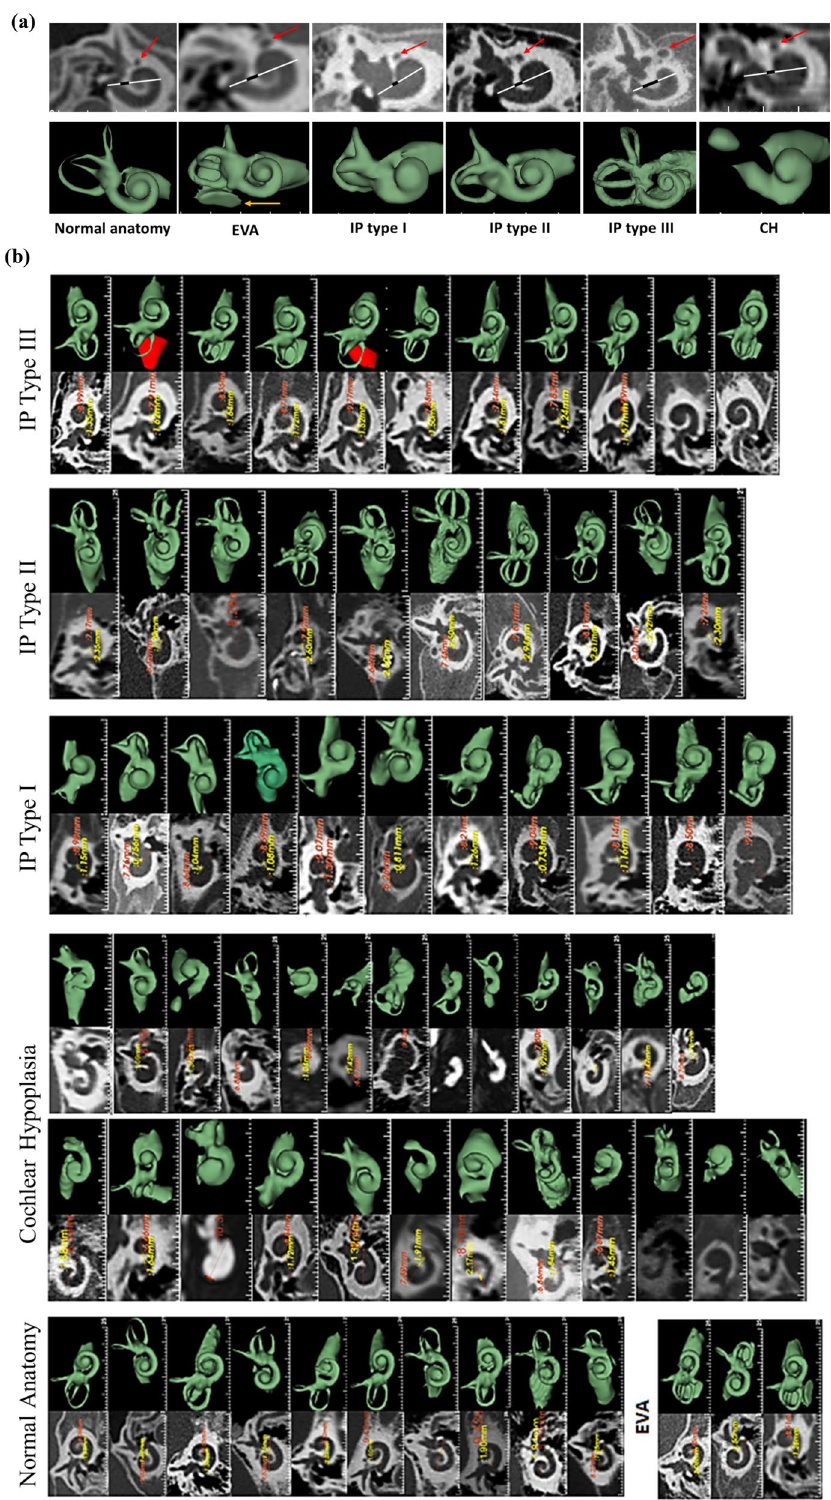
Figure 2. Two- and three-dimensional images of different cochlear anatomies, displayed in the oblique coronal plane/cochlear view, showing the A-value (white line), C-value (black line) and the facial nerve (red arrow) ( a ); and all seventy-four HRCT images of the cochlear samples used in the analyses along with the corresponding 3D images ( b